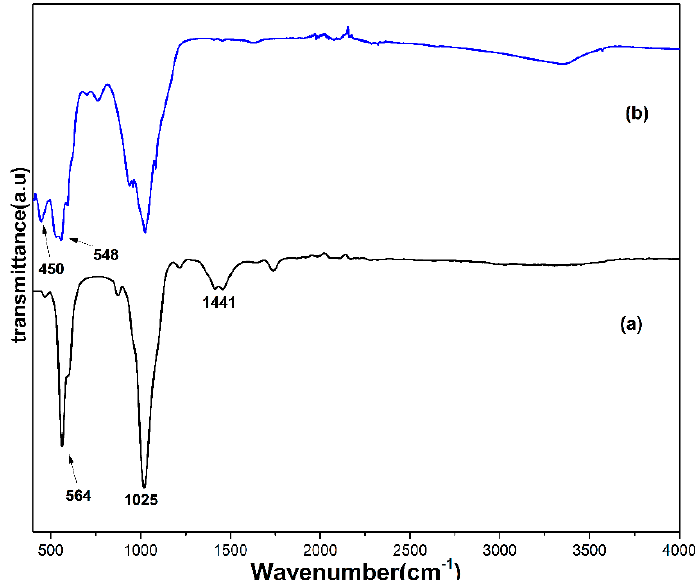
Figure 5. FT − IR spectra of ( a ) HAP and ( b ) HAP − MnFe 2 O 4 .